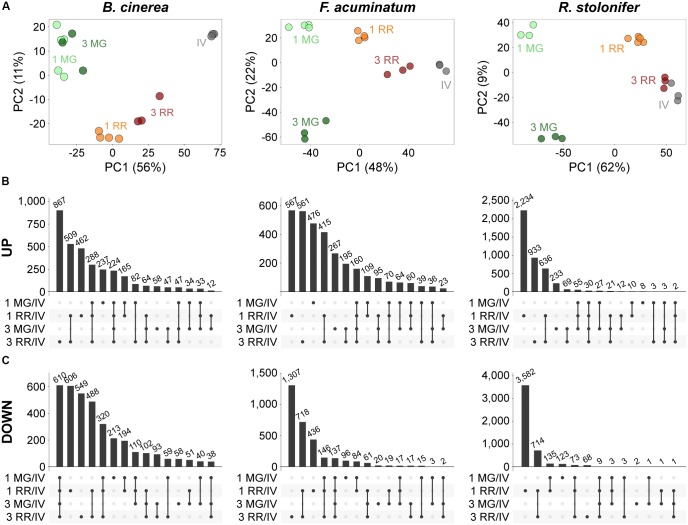
Principal component analysis (PCA) and intersections of differentially expressed genes (DEGs) during inoculations of tomato fruit. (A) PCA plots of variance-stabilized matrixes of mapped reads for each pathogen as generated by DESeq2. (B,C) UpSetR visualizations of intersections between the upregulated (B) and downregulated (C) DEGs of inoculated fruit at two time points versus in vitro comparisons for each pathogen. Intersections are displayed in descending order by number of genes. All datasets can be accessed in Supplementary Tables S5–S7.